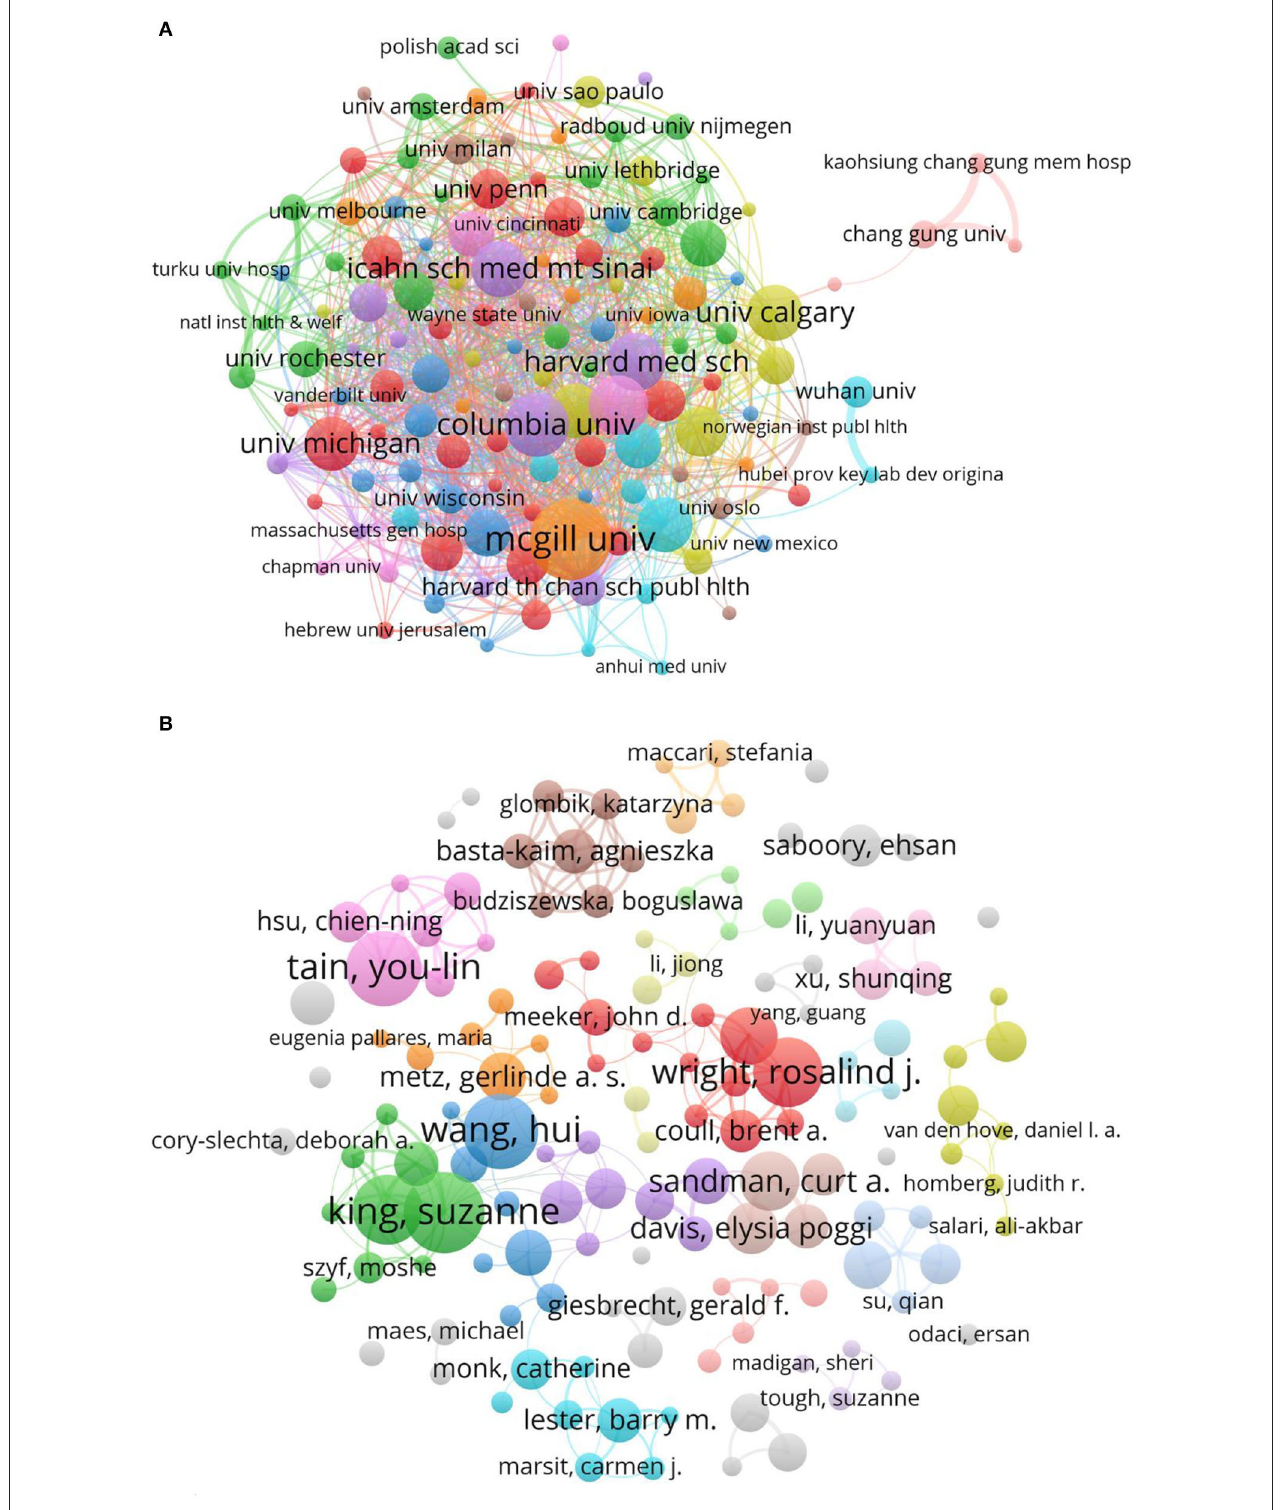
FIGURE 4 | Network of affiliations and authors related to PS. (A) Network of affiliations. Of the 5,601 affiliations, 131 affiliations had at least 25 documents. (B) Network of authors. Of the 28,795 authors, 140 authors had at least 10 documents.